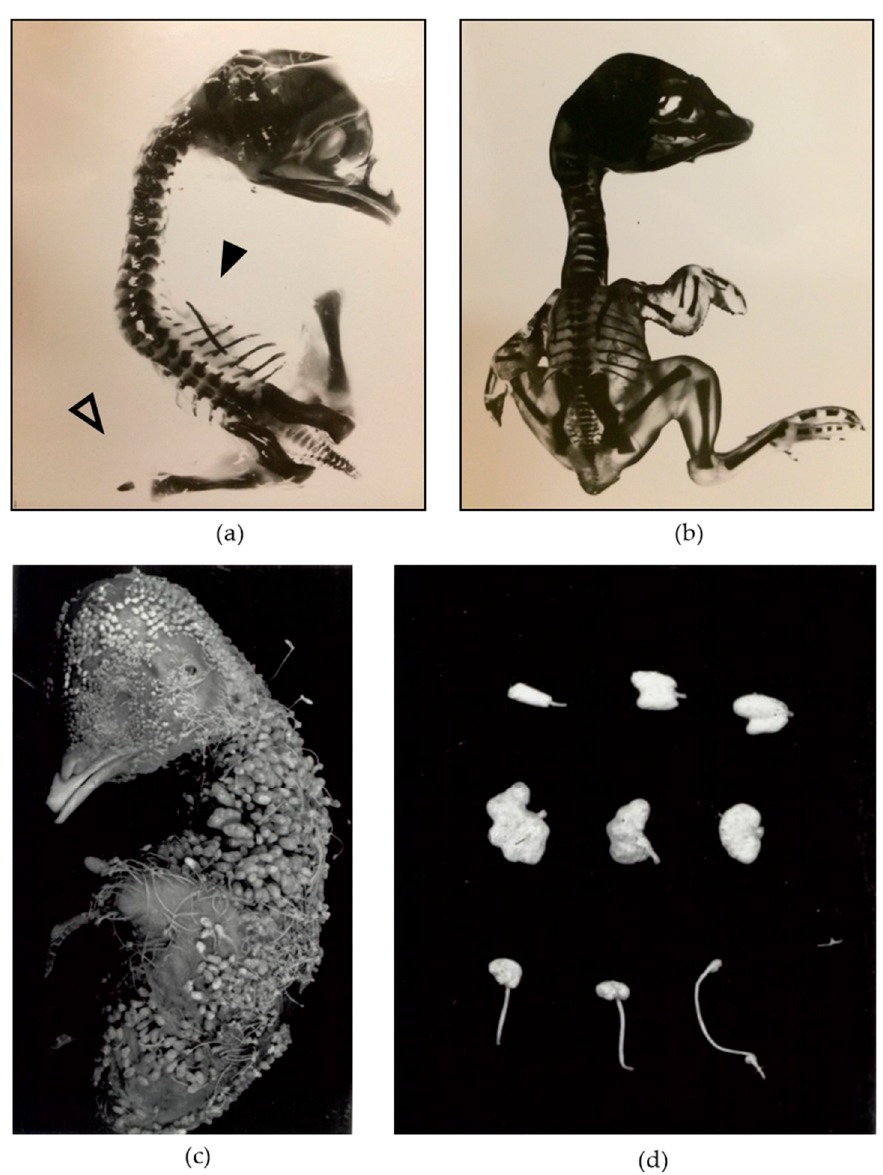
Figure 1. Phenotype of the wg-2 mutant illustrating wing, leg, and feather abnormalities. Shown here is ( a ) a wg-2 mutant embryo missing all elements of the forelimbs (wings) (solid arrowhead) and exhibiting truncated hindlimbs (legs) (open arrowhead), as compared with ( b ) a normal, wild-type embryo with limbs on the right side extended for visibility. The embryos were incubated to 18 days of incubation (DI) (mutant) and 19 DI (normal) and stained with Alizarin Red to highlight bone structure. ( c ) An 18 DI wg-2 embryo illustrates the severe feather abnormality. ( d ) Several wg-2 feathers are shown to portray the range of the abnormality. The top two rows show the most severely affected feathers: large and abnormally compound feathers lacking a filamentous shaft. The bottom row illustrates the more normal filamentous feathers that have basal dilations (called clubbed down and observed in other lines) and sometimes “blebs” at the distal tip of the filament (associated with the wg-2 phenotype). Reproduced and adapted with permission from Jacqueline Pisenti, “Genetic and environmental influences on the expression of the mutation wingless-2 in the chick embryo;” published by the University of California, Davis [7].